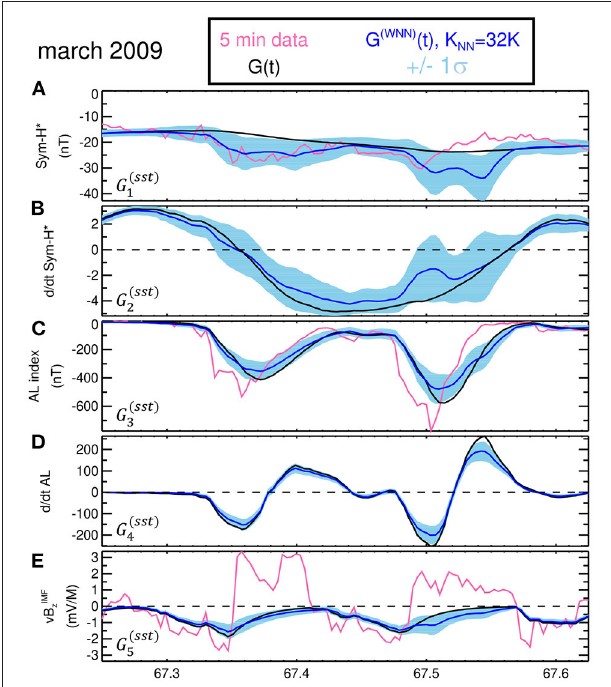
FIGURE 10 | Storm-substorm 5D state-space. (A–E) Time series of the five individual components (black lines) of the state-space used to characterize the combined storm and substorm state of the magnetosphere as defined in Equations (4)–(8) during the two 8 March 2009 substorms. Their standardized values are used to find K NN 32,000 nearest-neighbors (NNs) in the entire = state-space. The weighted mean of the 32,000 NNs are overplotted by the blue lines. The weighted standard deviation of the NNs is then overplotted by showing 1 σ as the light blue envelopes around the weighted NN ±